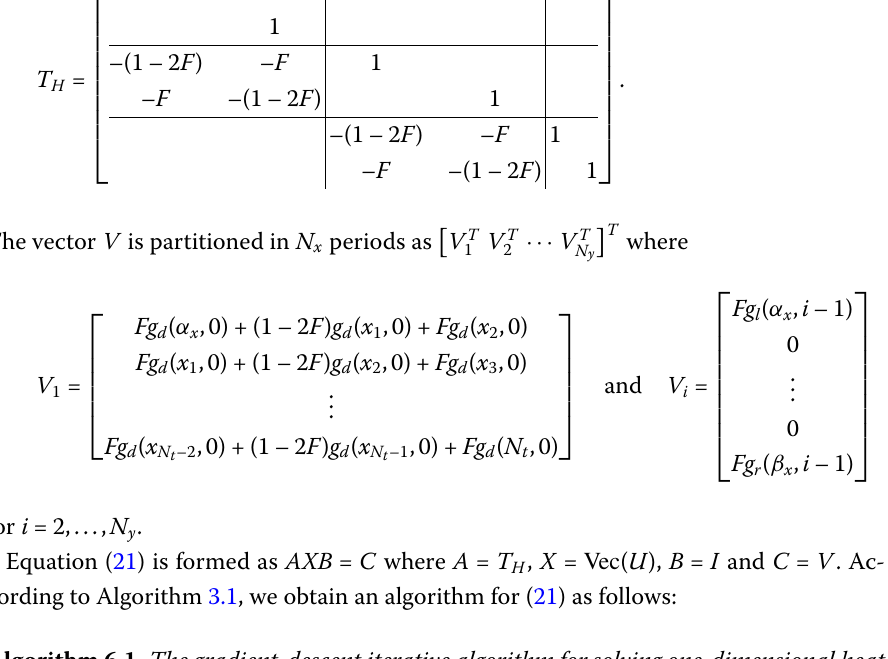
Algorithm 6.1 The gradient-descent iterative algorithm for solving one-dimensional heat equation